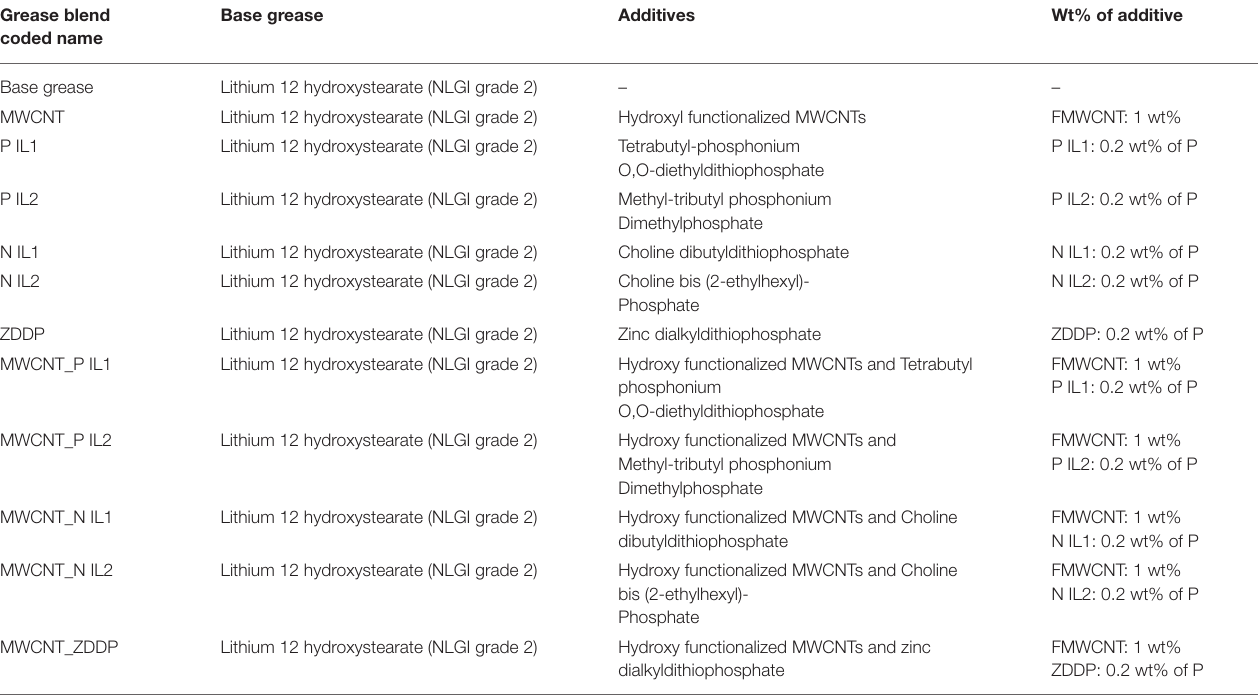
TABLE 2 | Overview of grease formulations and